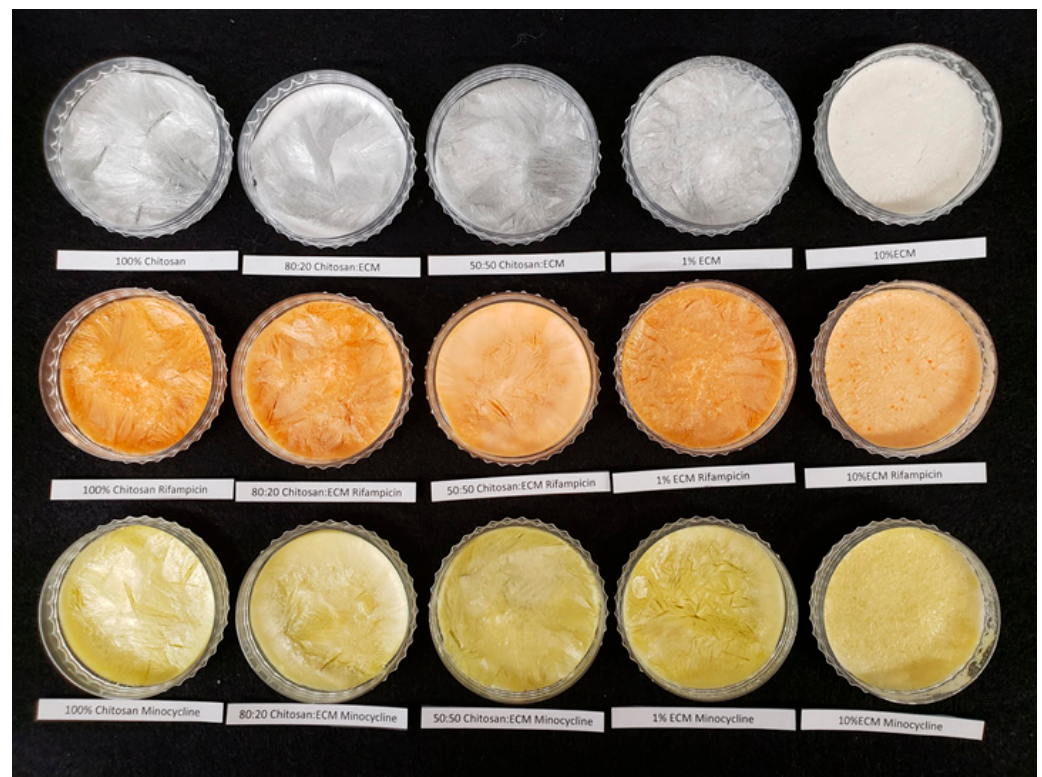
Figure 1. Representative images of the prepared scaffold materials with and without rifampicin and minocycline antibiotic. Scaffolds were formulated as 100% chitosan, 80/20 and 50/50 chitosan:extracellular matrices (ECM) hydrogel and 1% ( w / v ) and 10% ( w / v ) ECM powder in chitosan.